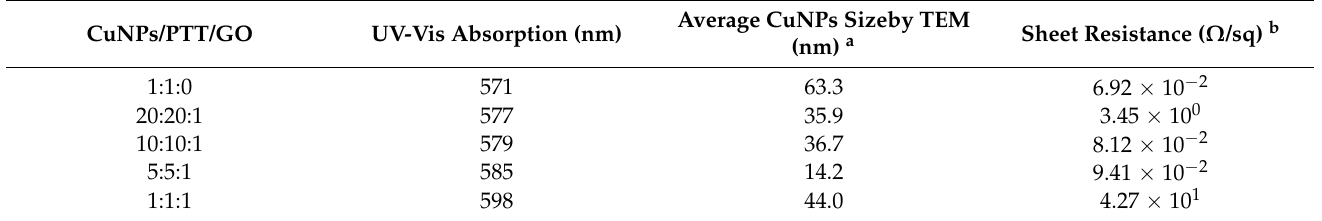
Table 1. UV-vis absorption peak intensity, average particle size, and sheet resistance of CuNPs/PTT/GO at different